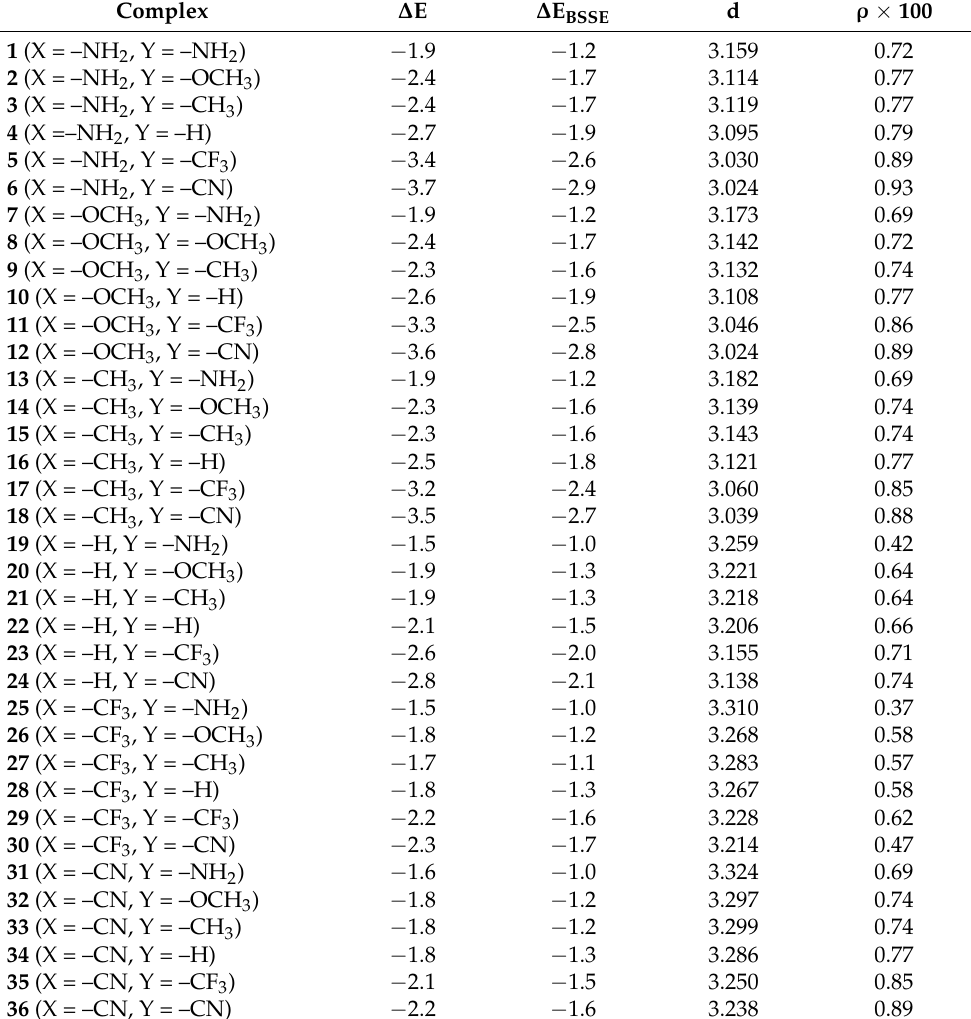
Table 2. Values of the uncorrected and BSSE-corrected interaction energies ( ∆ E and ∆ E BSSE , in kcal/mol), equilibrium distances (d, in Å) and value of the density ( ρ × 100, in a.u.) at the bond critical point (BCP) that characterizes the tetrel bonding interaction in complexes 1 to 36 . Complex ∆ E ∆ E BSSE d ρ ×